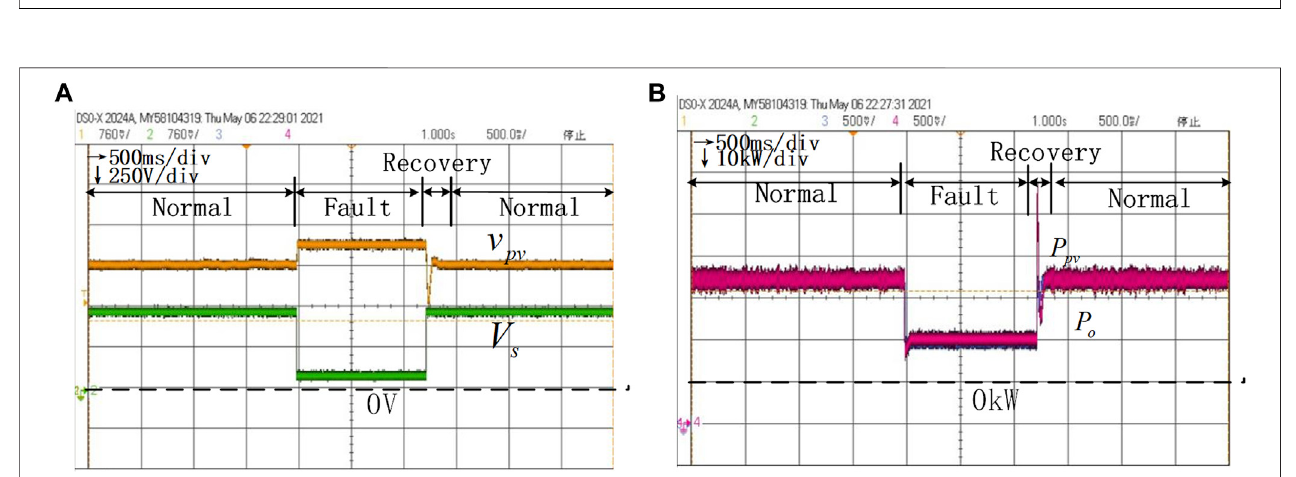
FIGURE 13 | HIL results of voltage dynamics and power dynamics without the variable parameter control under the conditions k p (cid:1) 0 . 1 , k i (cid:1) 5 , and C pv (cid:1) 20mF. (A) Voltage dynamics of v s and v pv . (B) Power dynamics of P o and P pv .